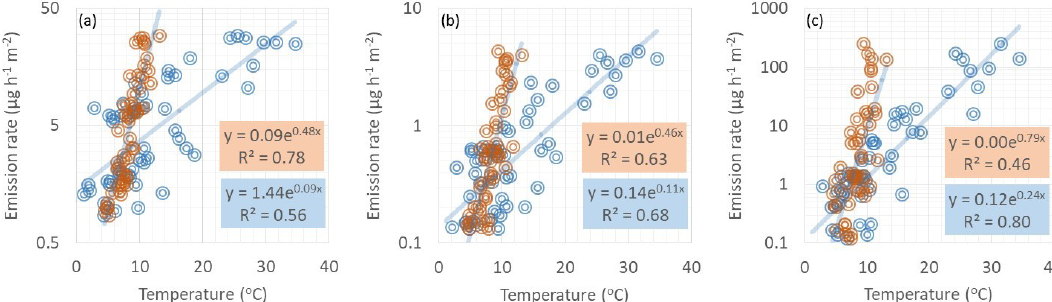
Figure 5. Correlation of (a) SQTs, (b) MTs and (c) isoprene emission rates with soil (orange dots) and chamber (blue dots) temperatures during the early growing season on 1–7 June 2018. Soil temperature was measured 5cm below the soil surface close to our emission chamber. R 2 values are from the corresponding transformed straight lines (ln( y ), ln( x